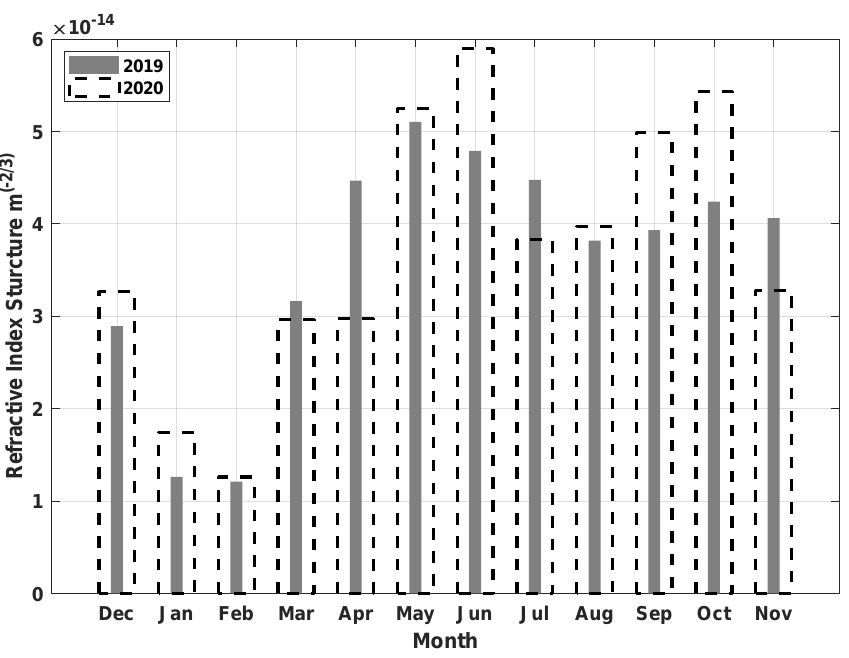
Figure 4. Month-wise Variation in C 2 n Under the Influence of Weather Conditions.